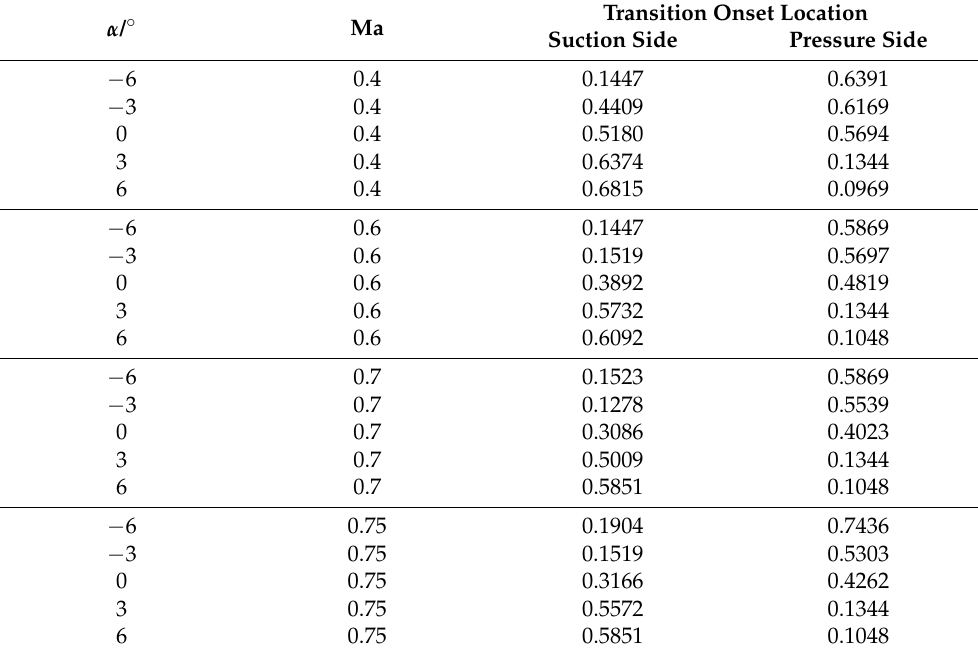
Table A6. Influence of angle of attack on transition onset location ( ε = 0.5%, T w = 293